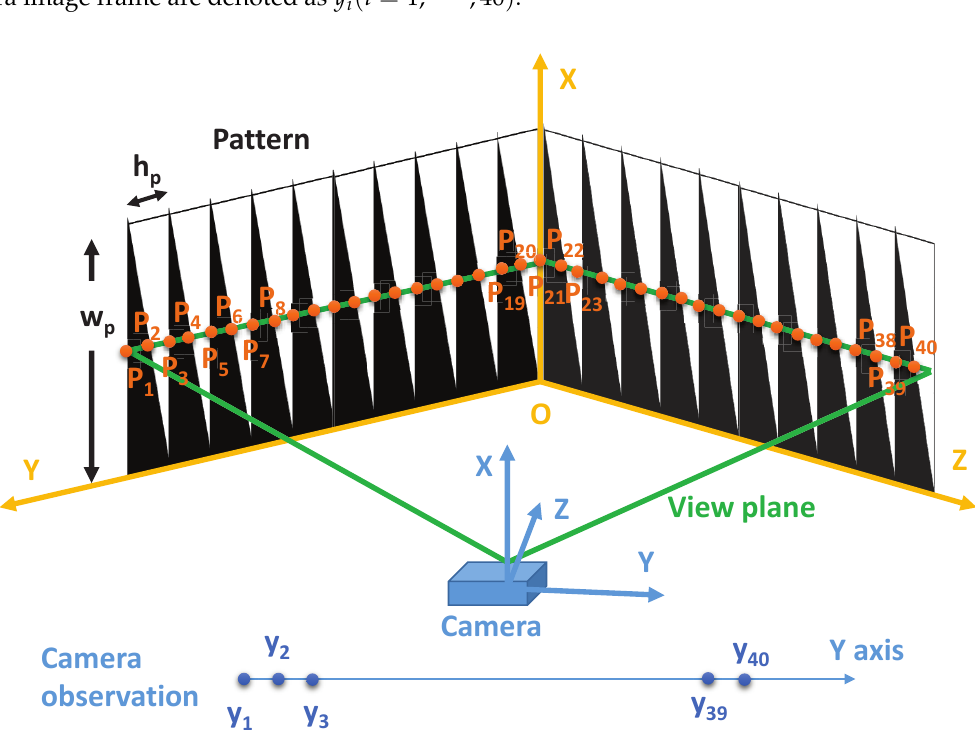
Figure 3. Calibration target used in the proposed method. w p and h p are the width and height of the triangles. The triangles are repeated using a constant offset of h p . The coordinate frame of the calibration target is denoted in orange and the coordinate frame of the camera is denoted in blue. The view plane of the line-scan camera is shown in green and intersects with the black triangles at points P i ( i = 1, · · · ,40 )